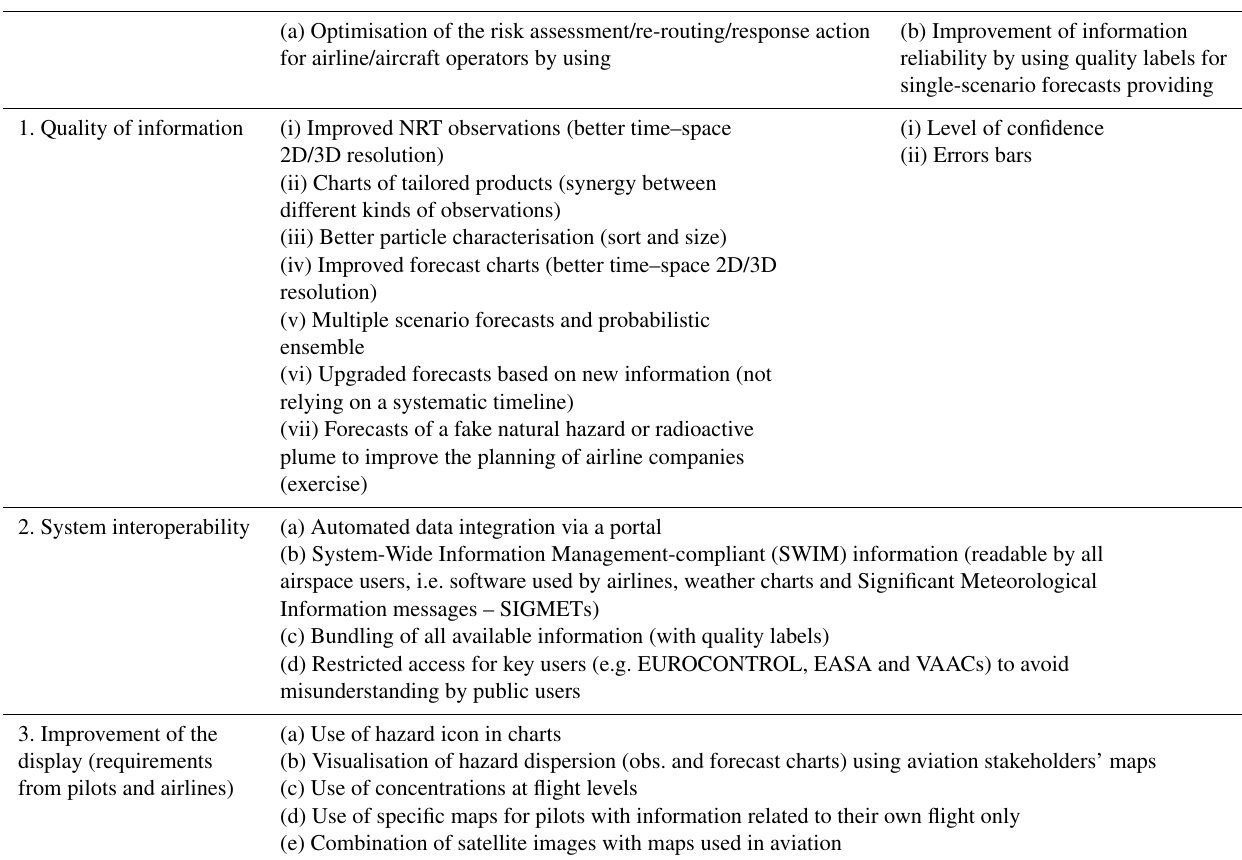
Table 1. Overview of user requirements.